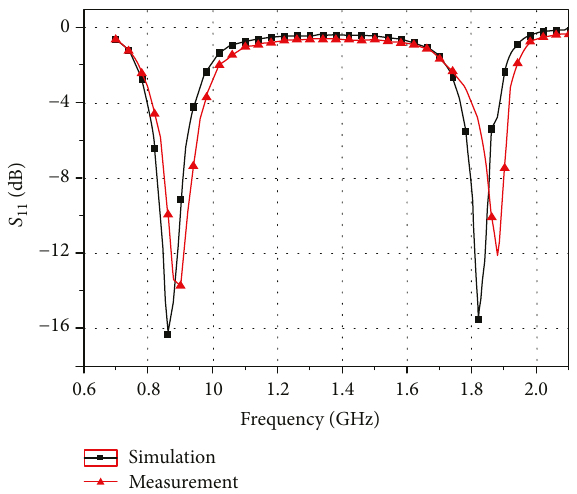
Figure 11: Simulated and measured RF-dc e ffi ciency versus load